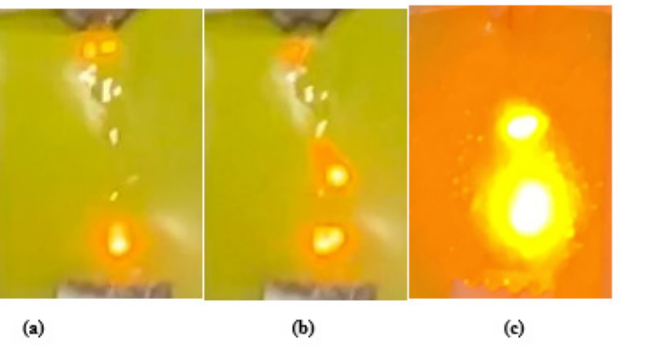
Figure 3. Pictures of the ( a ) initiation of discharges, ( b ) at mid and ( c ) before the end of the experi ‐ ment.